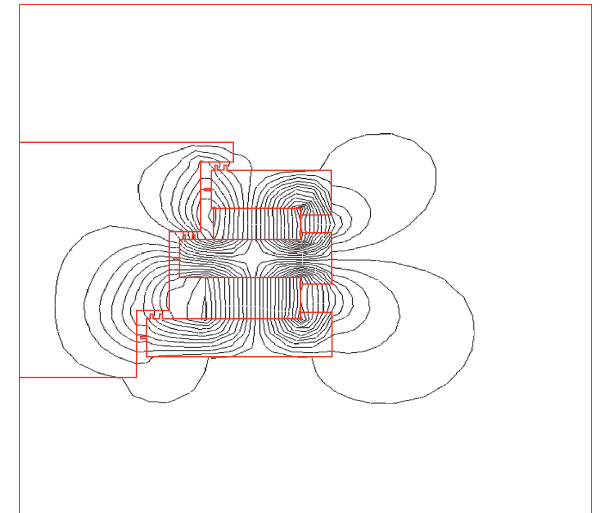
Figure 3: Distribution of magnetic flux density field lines of magnetic fluid